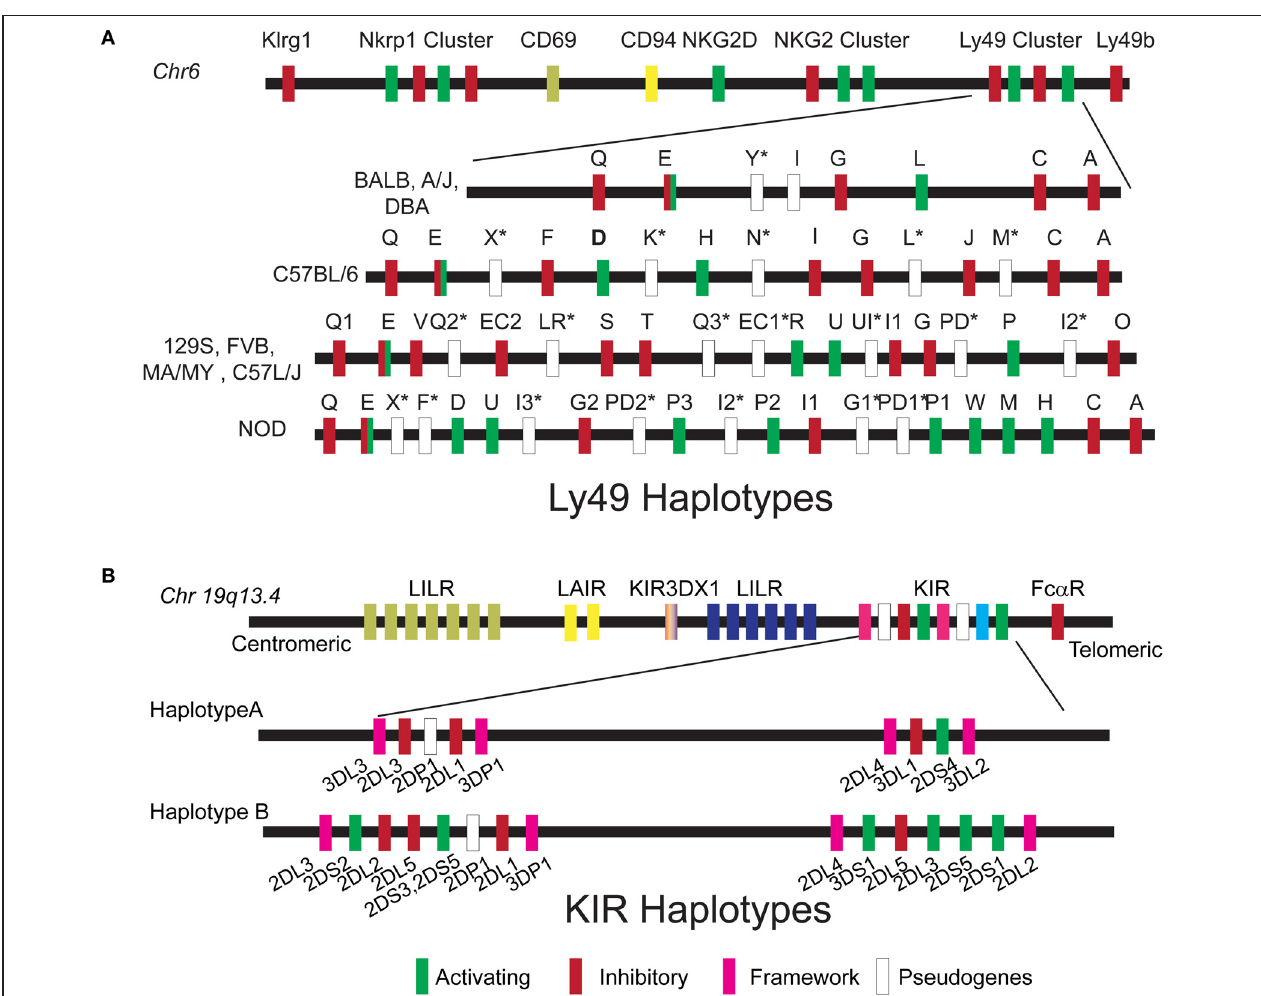
FIGURE 2 | Ly49 and KIR haplotypes. (A) The Ly49 gene cluster is located on chr 6 within the Natural Killer gene Complex. Schematic organization of the Ly49 haplotype is described for the inbred mouse strains that were used to map NK cell function by QTL. (B) The KIR gene cluster is located on chromosome 19q13.4 within the leukocyte receptor complex. Two basic haplotypes A and B have been defined, varying in the number of activating